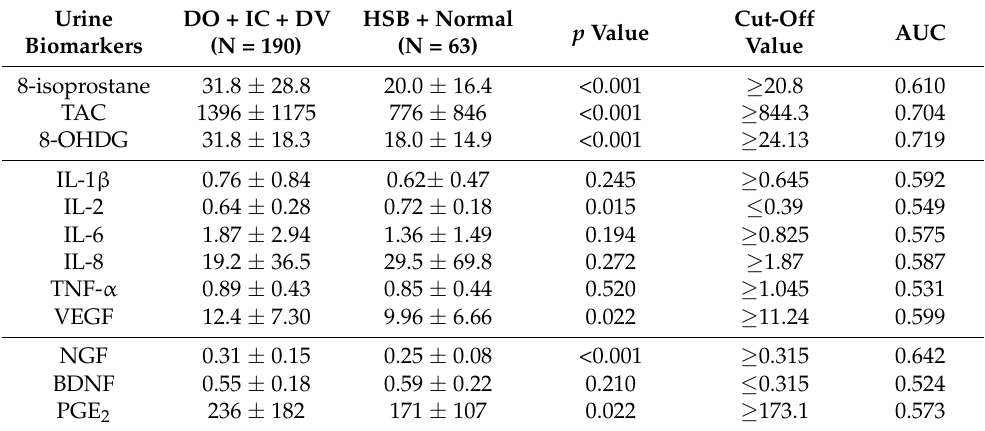
Table 3. Urine biomarkers in women with DO, IC/BPS, and DV compared to women with HSB and normal